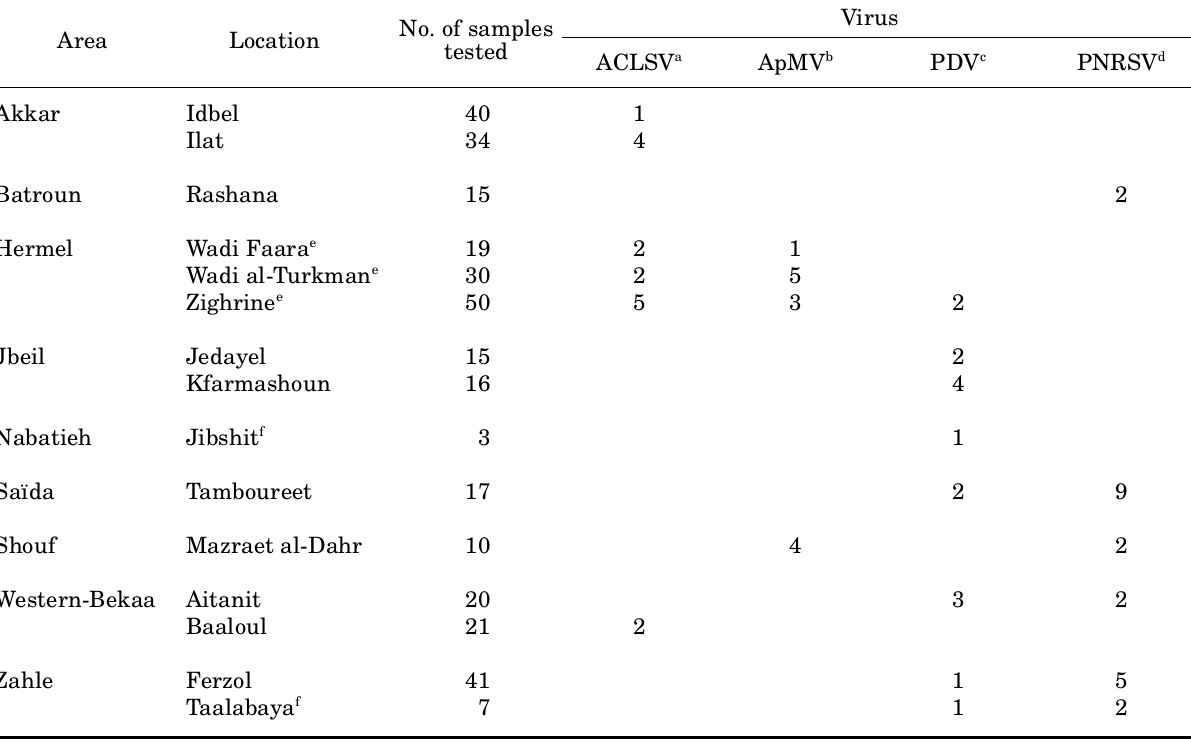
Table 1. Locations and areas where viral diseases on almonds were detected.